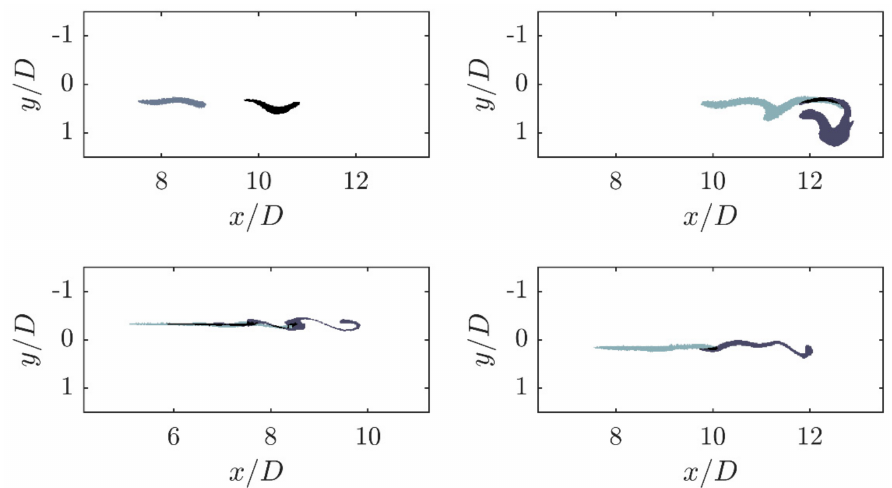
Figure 15. Overlay of the droplet images on two consecutive frames. Due to the short time offset, the deformation of the individual droplet filaments can be